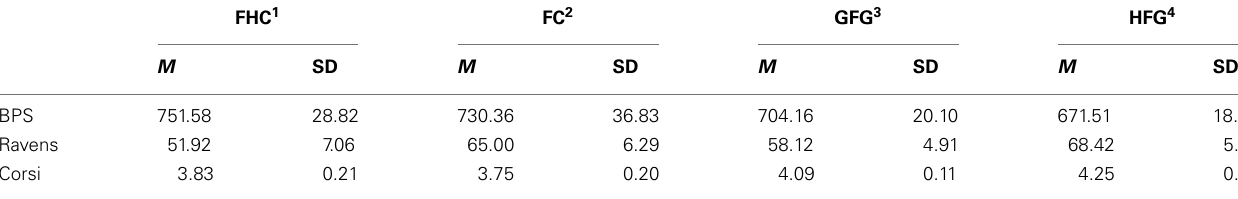
Table 4 | Reaction time, Ravens and Corsi measures as a function of Finger Gnosia subgroup.